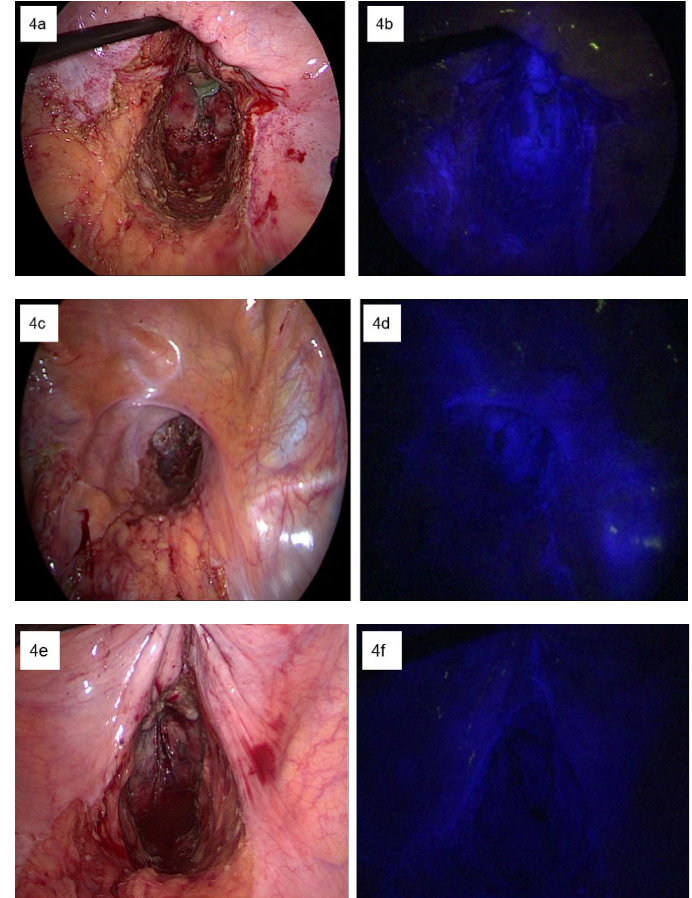
Figure 3. The ICG fluorescence signal in the lateral pelvic sidewalls. ( a ) The gross appearance of the lateral pelvic sidewall in a color image. ( b ) The color image overlaid with the ICG fluorescence. ( c ) The pure ICG fluorescence image under NIR light.